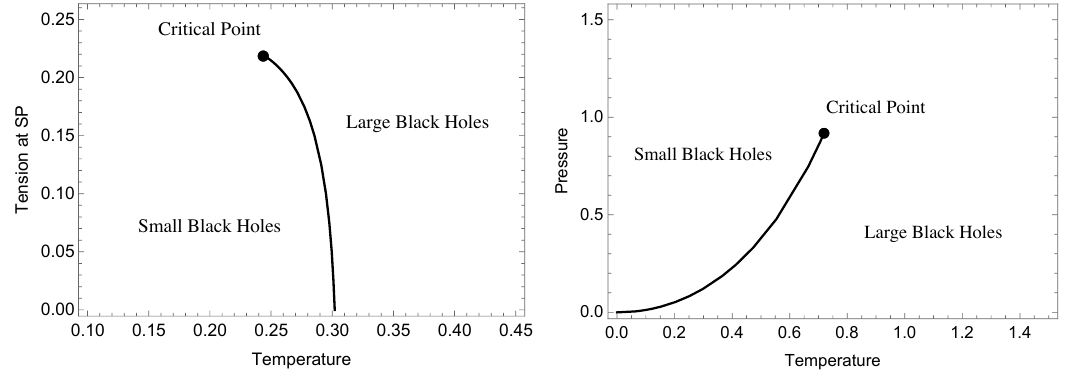
Figure 6 . The coexistence line for the charged black hole shown for varying tension and cosmo- logical constant with the black hole charge is (cid:12)xed at Q = 0 : 05. On the left, ‘ = 1, and the value of tension at the critical point is (cid:22) c = 0 : 219. On the right, 4 (cid:22) (cid:0) = 0 : 3, and the critical value of the AdS radius is ‘ c = 0 :